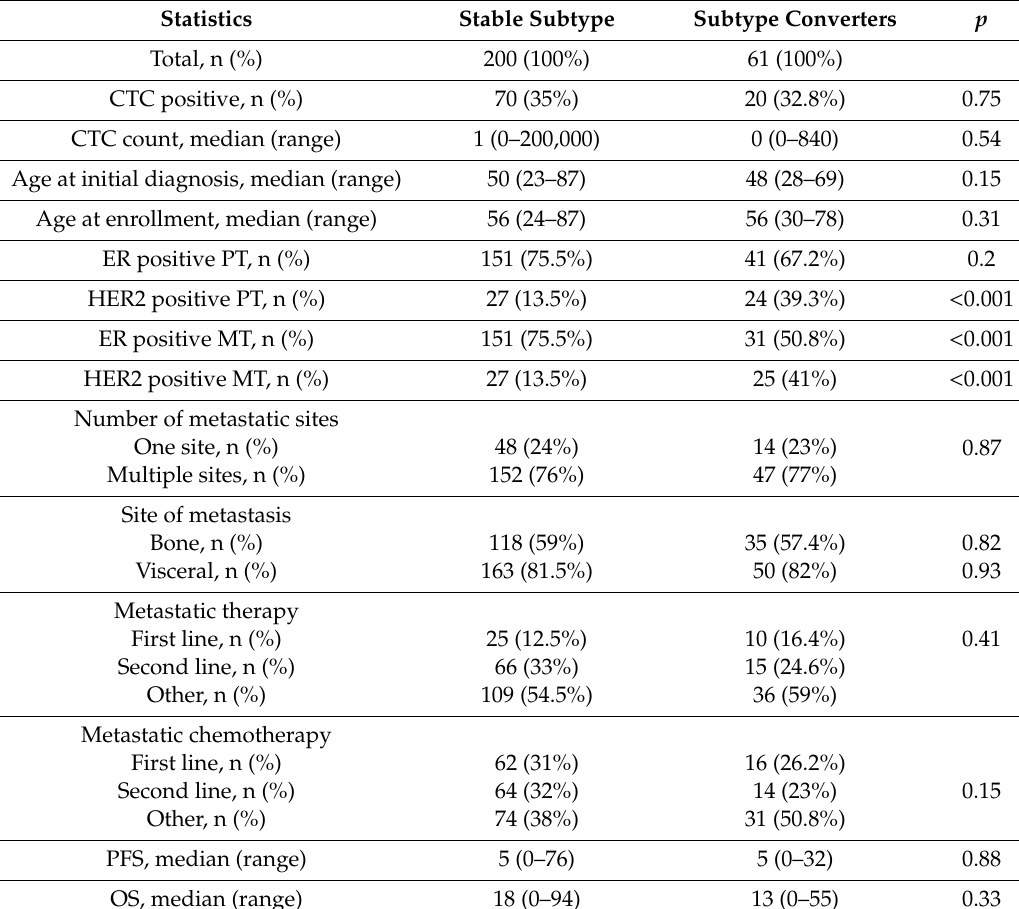
Table 1. Demographic and clinical characteristics, CTC status, CTC count, PFS and OS according to tumor subtype